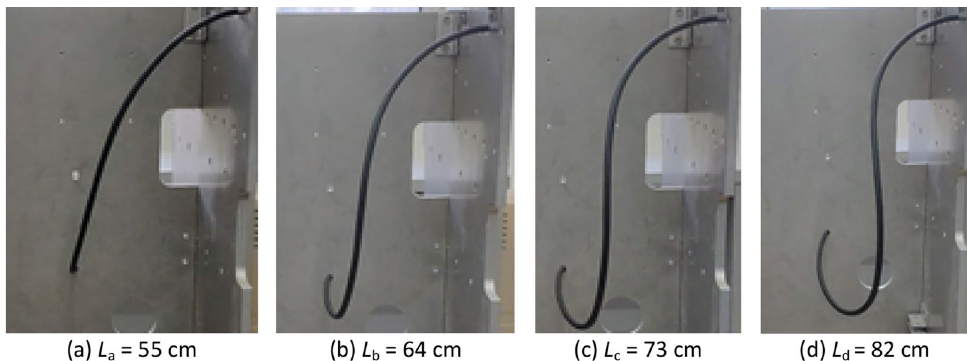
Figure 13. Cable experimental shape change with increasing